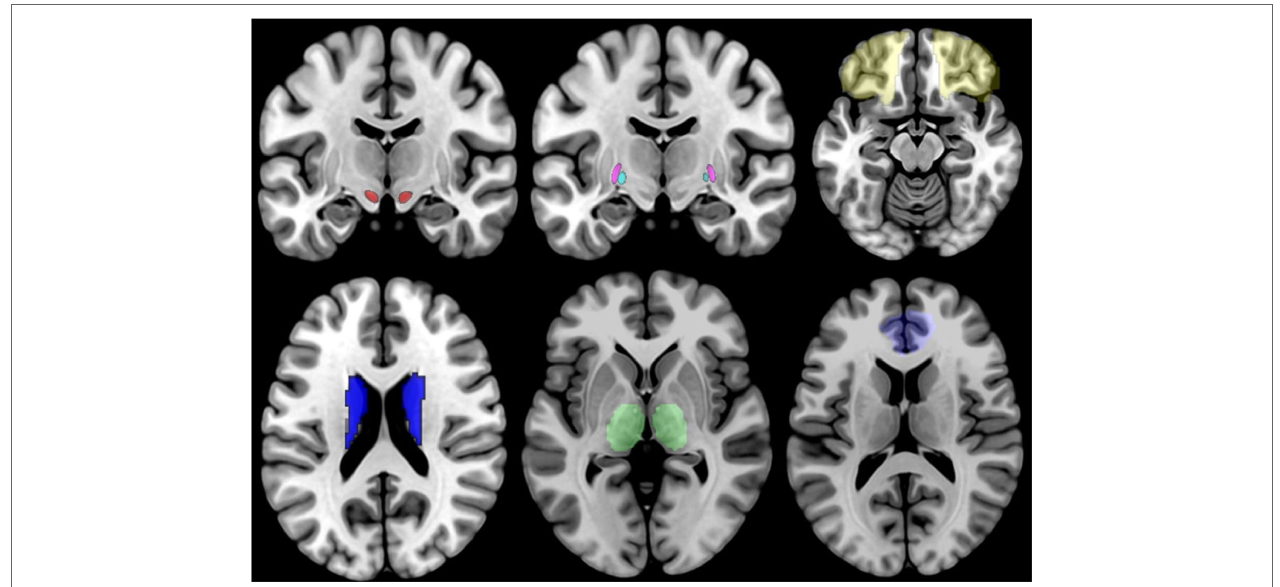
FIGURE 1 | Illustration of the 14 ROIs, with the STN shown in red, the GPi shown in cyan, the GPi shown in violet, the OFC shown in yellow, the striatum shown in blue, the thalamus shown in green, and the ACC shown in light blue. STN, subthalamic nucleus; GPi, internal globus pallidus; OFC, orbitofrontal cortex; ACC, anterior cingulate